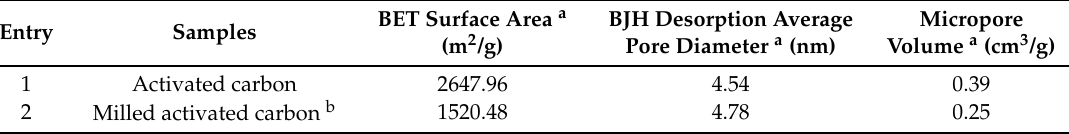
Table 5. Specific surface area and porosity of samples.